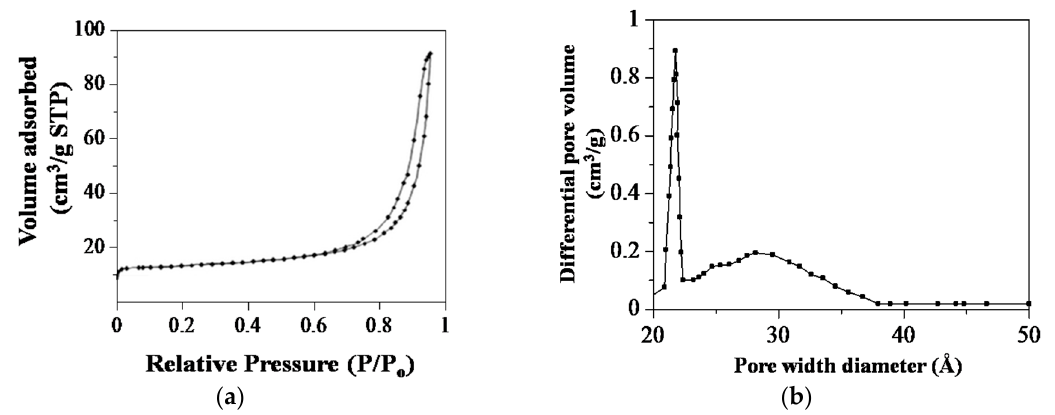
Figure 6. Nitrogen adsorption–desorption measurements ( a ) Isotherms plot; and ( b ) Barrett–Joyner– Halenda (BJH) models.